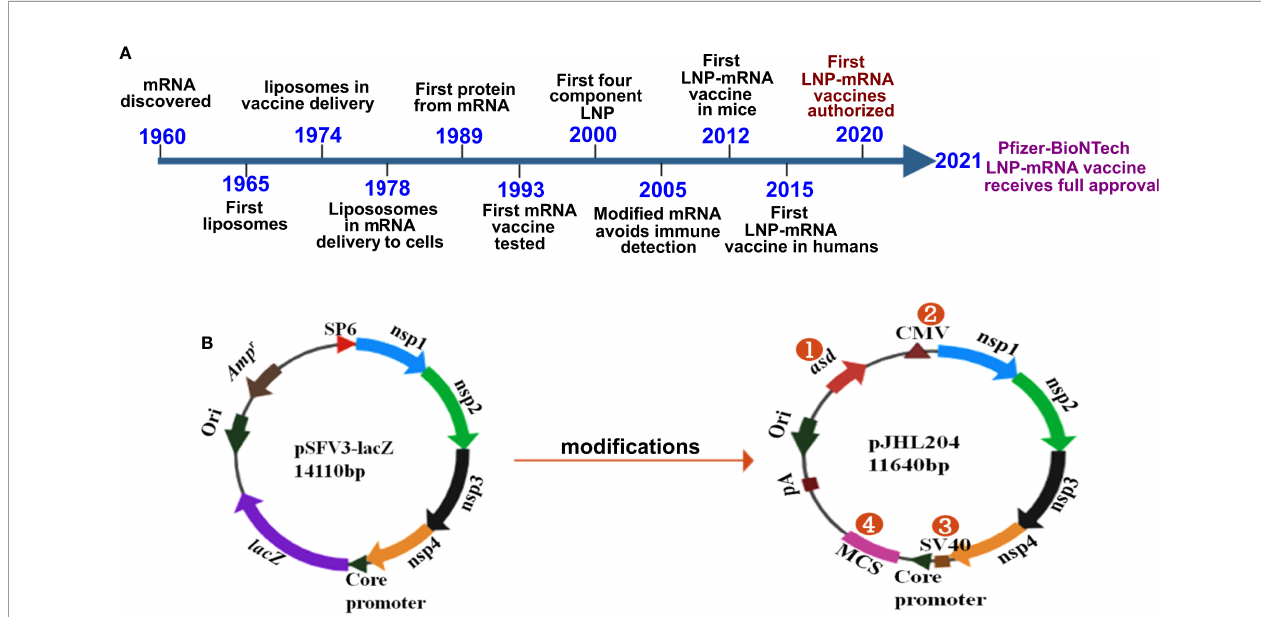
FIGURE 1 | History and design of mRNA vaccines. (A) Timeline depicting some of the key milestones that contributed to the fi rst successful mRNA vaccines developed against COVID-19. The timeline was adapted from Sahin et al., 2014 (ref. 27) Hou et al., 2021 (28); and Dolgin, 2021 (29). (B) The DNA-launched-mRNA vaccine design for bacterial delivery. pSFV3-lacZ, an SFV replicon-based vector, was used after making several modi fi cations. 1- The ampicillin resistance marker was replaced with asd, an auxotrophic marker to enable antibiotic-free maintenance and delivery of the vector. 2- The SP6 promoter was replaced with the cytomegalovirus (CMV) promoter. 3- The SV40 promoter was placed just before the SFV sub-genomic core promoter to enable direct nuclear transcription of the vaccine constructs. 4- lacZ was replaced with multiple cloning site (MCS) sequences. nsp 1-4 from SFV constitute the replicon, which drives ef fi cient transgene expression through RdRp. pA, polyadenylation signal; Ori, pBR origin of replication; RdRp, RNA dependent RNA polymerase; nsp, non-structural protein; SFV, Semliki Forest